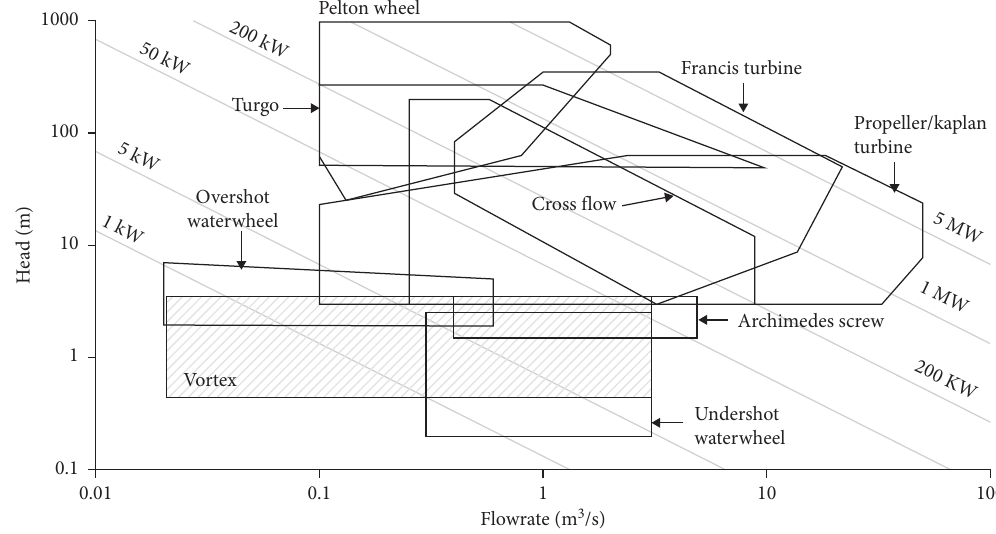
Figure 2: Operational area of GWVPP (adapted from [6]).